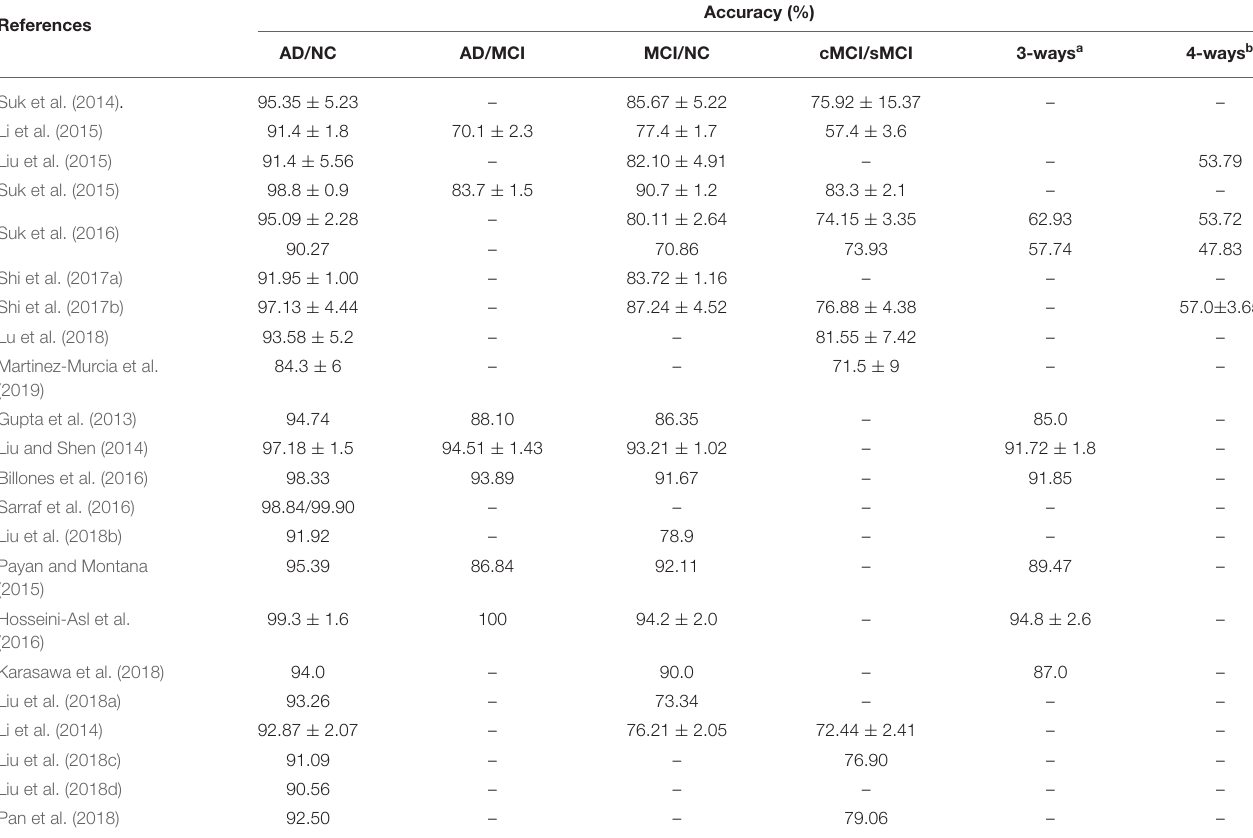
TABLE 2 | The classification performance of papers for AD diagnosis.